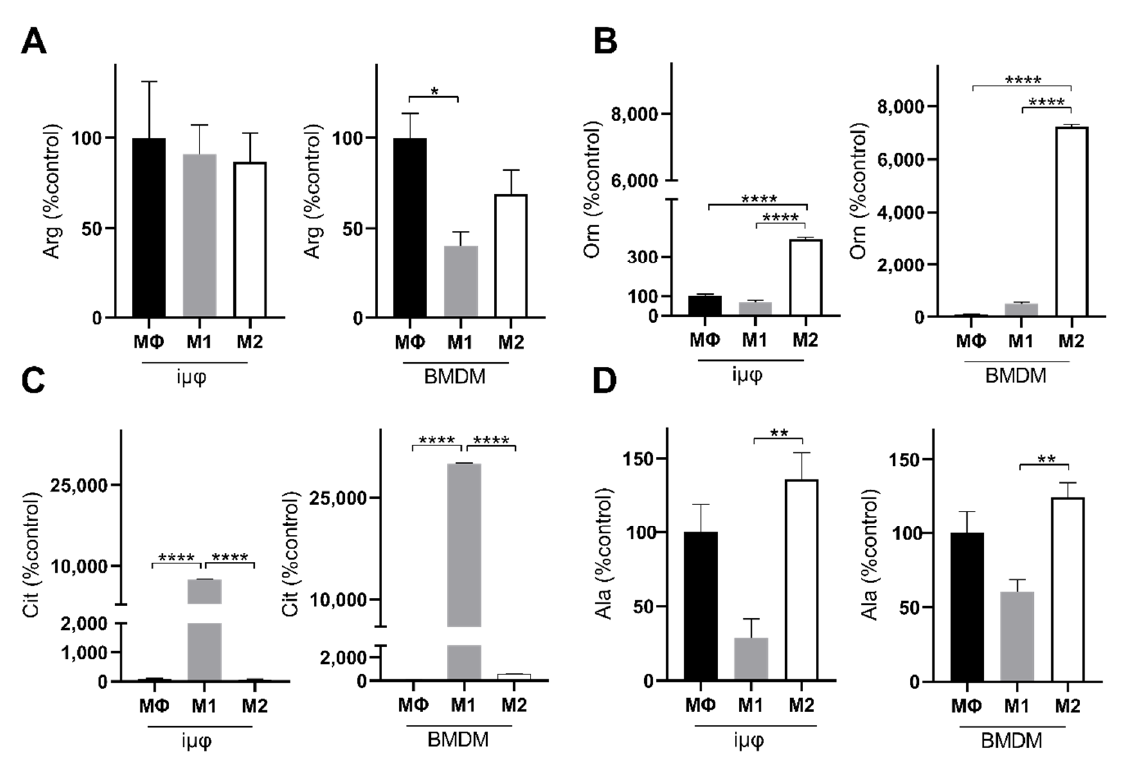
Figure 6. M1- and M2-stimulated i µ Φ and BMDM macrophages display similar metabolic features for key amino acids. LC-MS/MS quantification of arginine (Arg, ( A )), ornithine (Orn, ( B )), citrulline (Cit, ( C )) and alanine (Ala, ( D )) in resting (M Φ )-, M1- and M2-stimulated i µ Φ ( n = 3) and BMDM macrophages ( n = 3). Data are means ± SEM. * p < 0.05, ** p < 0.01, **** p < 0.0001.